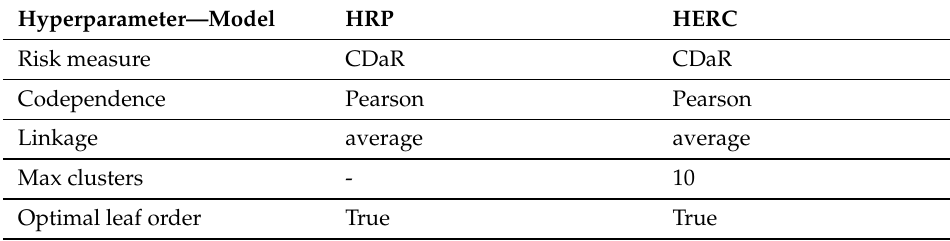
Table 1. Hyperparameters for the HRP and HERC models.